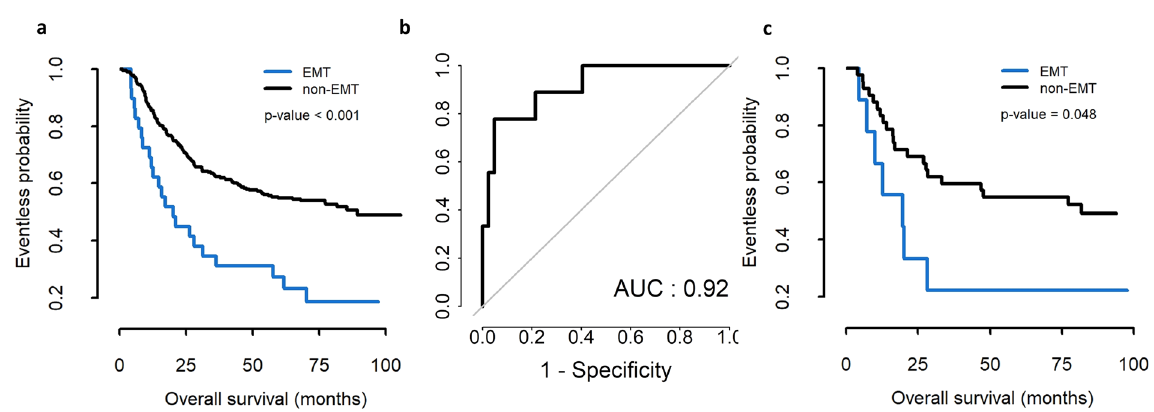
Figure 5. ( a ) Survival difference in patients with gastric carcinoma with EMT and non-EMT subtypes separated by prediction model with 10 genes in the ACRG cohort using fresh tissue specimens and calculated by the ROCR package. ( b ) The prediction of EMT subtype by 10-gene prediction model in the ACRG group. The sensitivity was 0.957 and the specificity was 0.811, with AUC of 0.92. ( c ) Survival differences in the present 50 RNA-Seq data with archival tissue